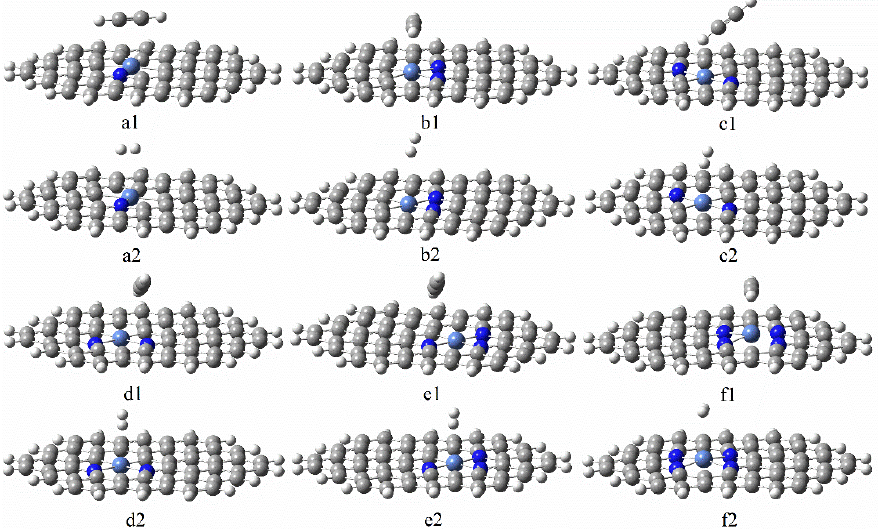
Figure 4. The most stable adsorption structures of C 2 H 2 and H 2 on graphene-NiN 1 ( a1 , a2 ), graphene- NiN 2 (A) ( b1 , b2 ), graphene-NiN 2 (B) ( c1 , c2 ), graphene-NiN 2 (C) ( d1 , d2 ), graphene-NiN 3 ( e1 , e2 ), and graphene-NiN 4 ( f1 , f2 ). Table 2. Single and co-adsorption energies of C 2 H 2 and H 2 adsorbed on graphene-NiN x (x = 1, 2, 3, 4) catalysts (energy unit: kcal/mol).